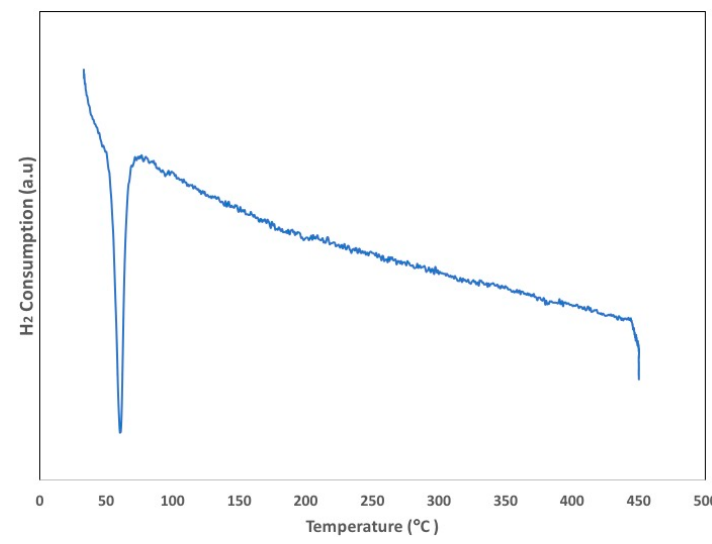
Figure 10. Temperature-programmed reduction (TPR) of the catalyst.